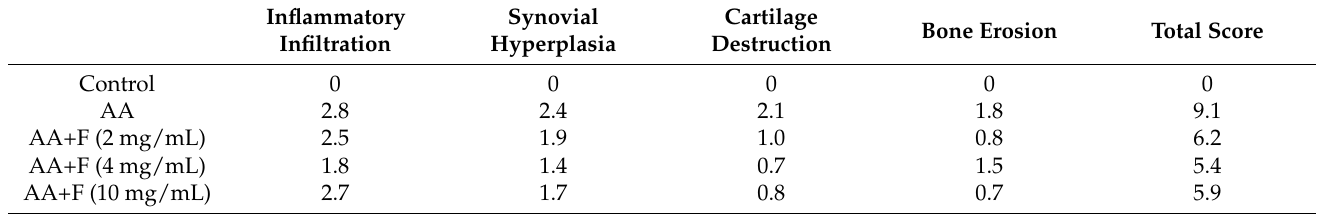
Figure 6. Ankle joint tissues of hind paws of treated and untreated arthritic rats were histologically examined after H&E staining ( × 400). Joint structures in rats of the AA group were severely damaged, synovial cells were aggregated, and nuclei were structurally abnormal and larger than normal nuclei. Treatment of arthritic rats with the 50% ethanol extract of RsB BM extract led to reduced inflammation-induced synovial damage but did not restore synovial tissues to a normal state. Table 1. Arthritis score sheet ( n = 6). For each group, scores for inflammatory infiltration, synovial hyperplasia, cartilage destruction, and bone erosion are listed.